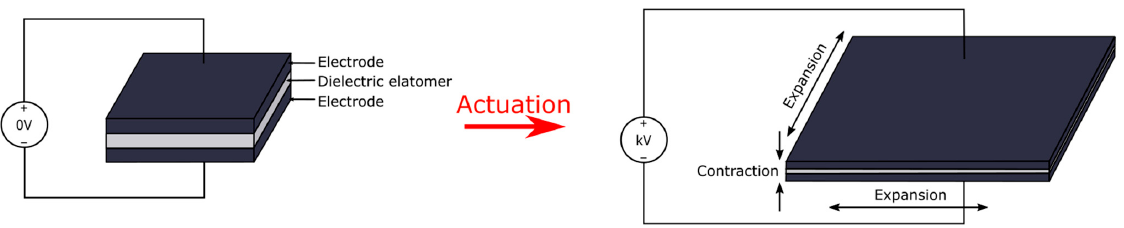
Figure 2. The actuation scheme of a typical sandwich-structured DEA. Upon the application of a high voltage (typically in the kilovolts range), the electrostatic force created between the top and bottom electrodes will squeeze the actuator, thus creating areal expansion and linear contraction in the third dimension (thickness in this case).